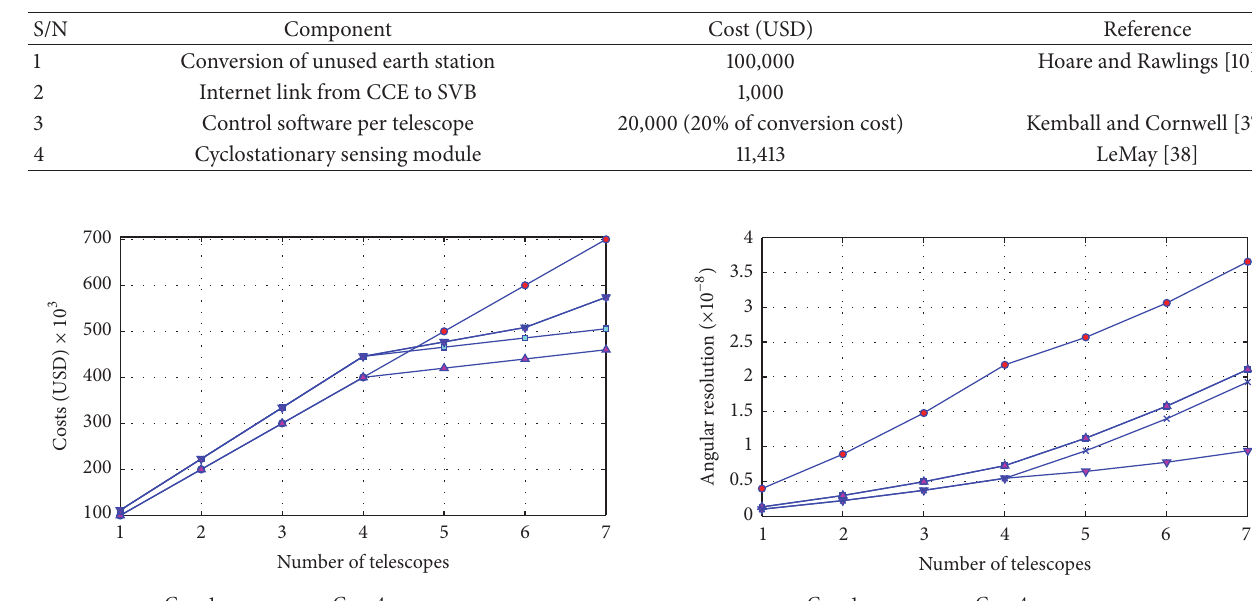
Table 3: Cost figures used to simulate ownership costs.